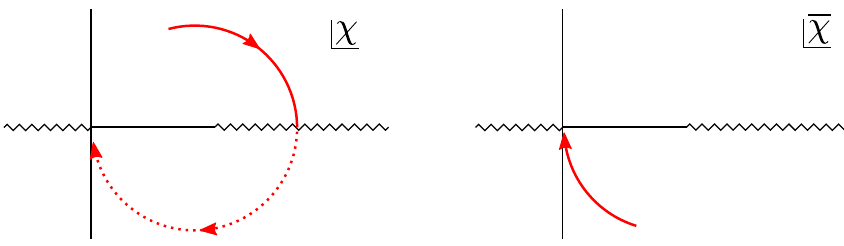
Figure 14 . The paths taken by the cross ratios (cid:31); (cid:31) as we continue from t = 0 to larger values of t . The dotted line indicates that (cid:31) has passed under the branch cut onto the second sheet. by dimensional analysis. Because we have divided by the two-point functions in de(cid:12)ning F ( t; x ), it is conformally-invariant and therefore only a function of the two cross ratios (cid:31); (cid:22) (cid:31)